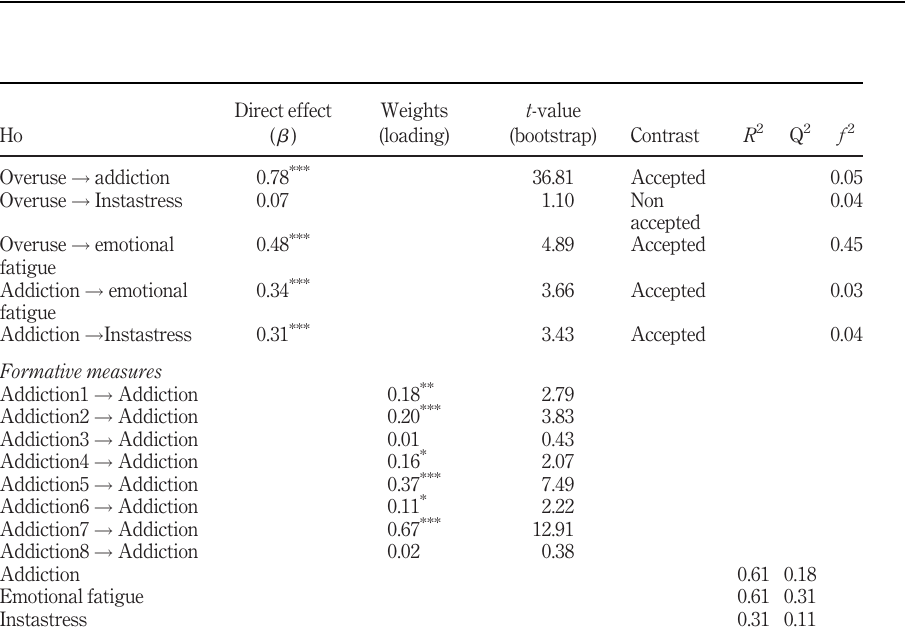
Table III. Direct effects